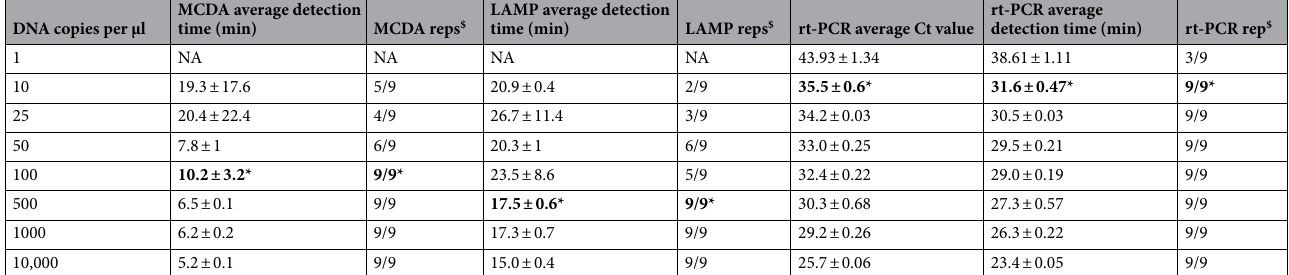
Table 1. Comparison of the sensitivity and time to detection for MCDA, LAMP and rt-PCR targeting the N gene from 3 independent runs. NA no amplification detected. *Limit of detection. $ reps: 3 runs with 3 technical replicates = 9 replicates.